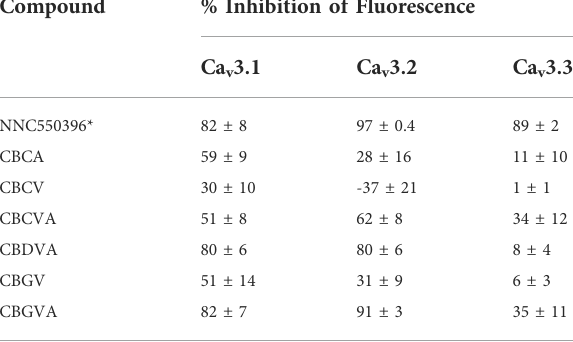
TABLE 1 % inhibition of 10 mM Ca-induced fl uorescence by phytocannabinoids (10 µM) at T-type calcium channels using FLIPR assay in HEK293